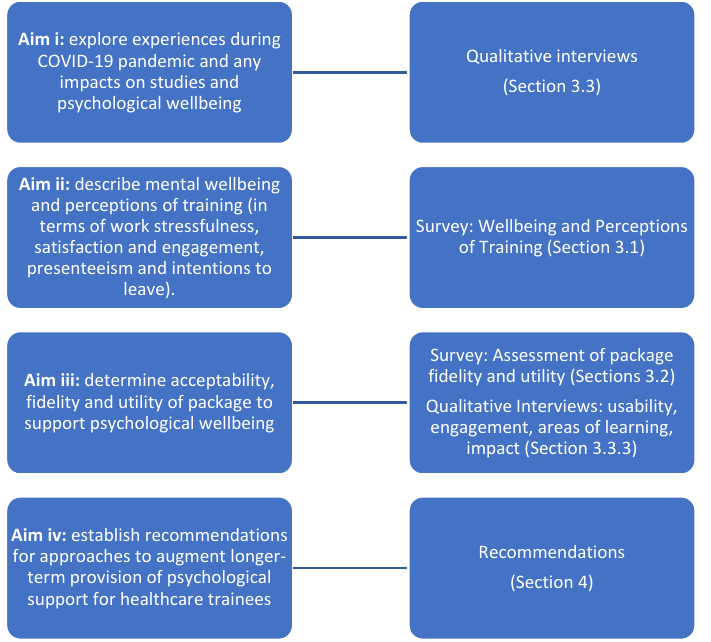
Figure 2. Approaches to data collection.